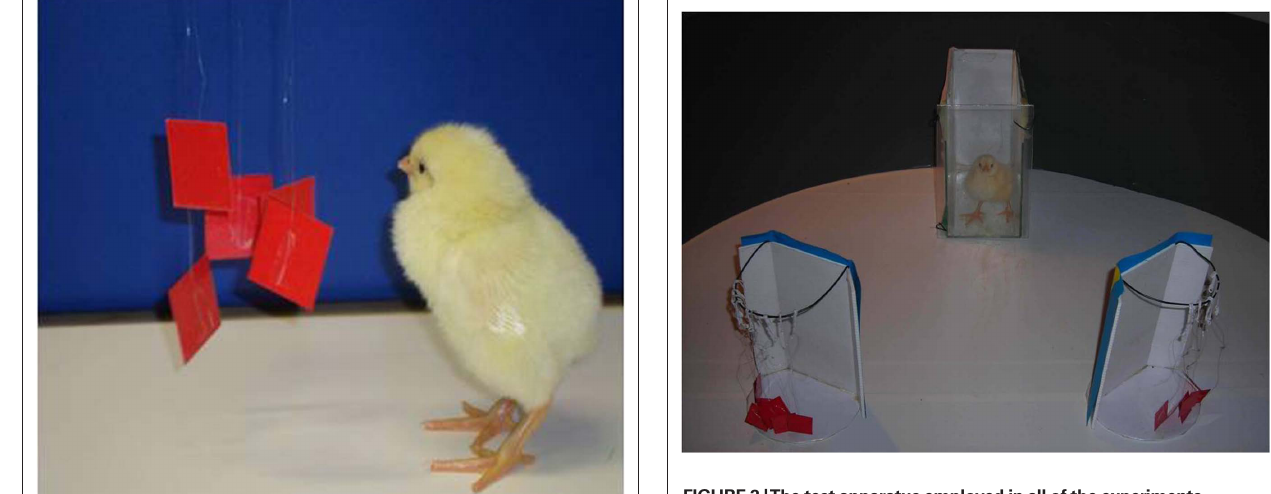
Figure 2 | The test apparatus employed in all of the experiments described. In the picture, a chick, confined into the starting box, and the two screens, as during the test phase, are present. The stimuli, each composed of five or 10 identical squares (as in the No Control condition of Exp. 2) are